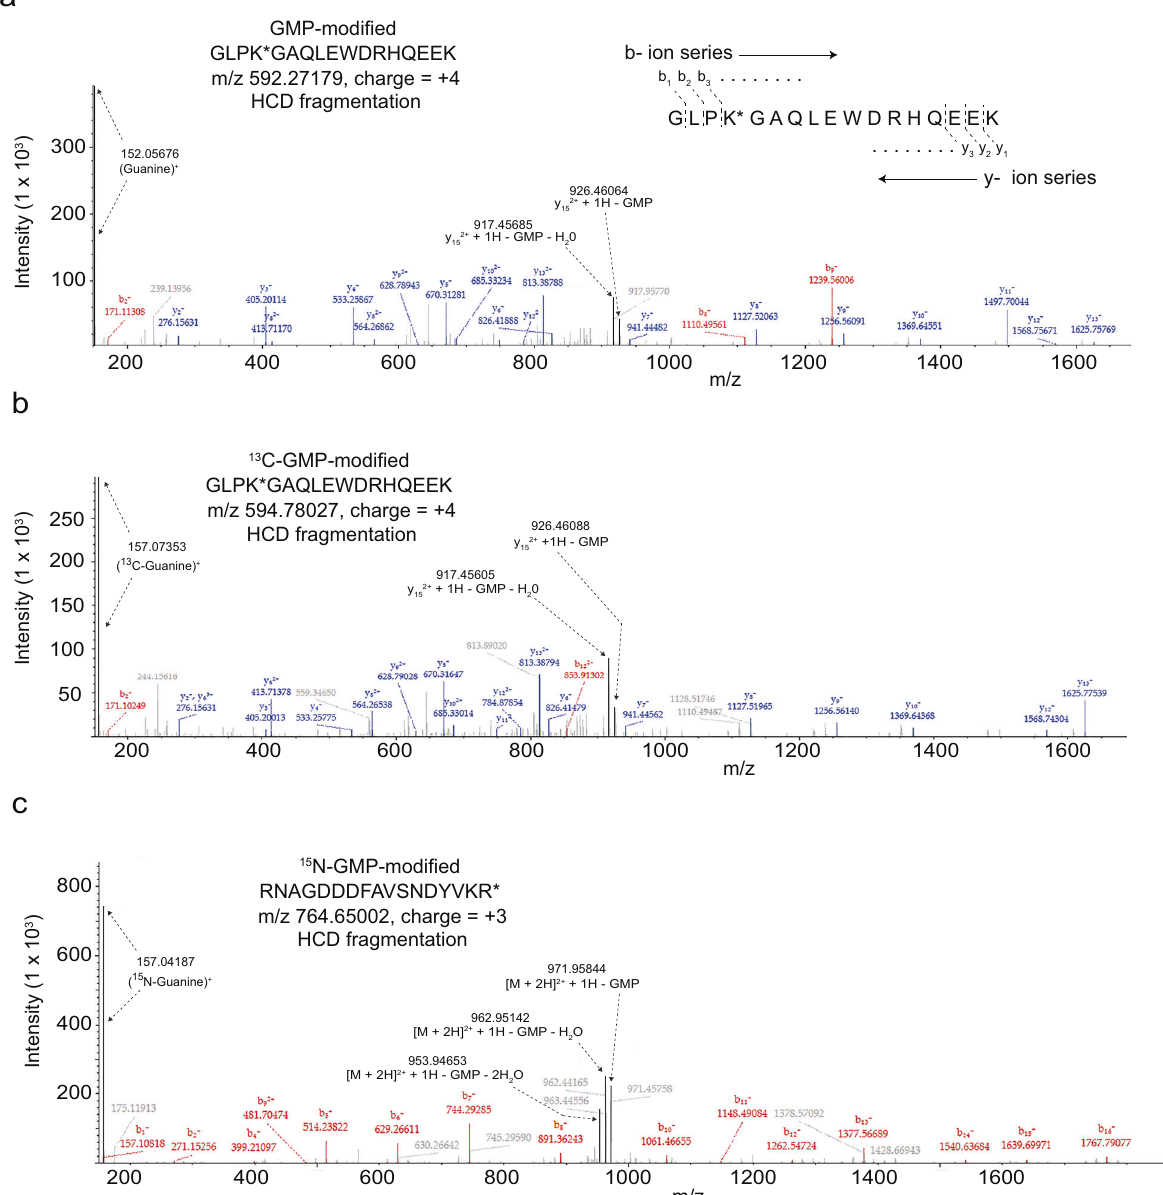
Fig. 3 MS/MS spectra of GMP, 15 N-GMP and 13 C-GMP modi fi ed peptides fragmented with HCD. a Top-scoring HCD peptide spectrum match for an EAV nsp7 peptide that is labeled close to the N-terminus with GMP. Ion series fragmentation for this peptide is illustrated. b Top-scoring HCD peptide spectrum match from an EAV nsp7 peptide that is labeled close to the N-terminus with 13 C-GMP. c Top-scoring HCD peptide spectrum match from an EAV nsp7 peptide that is labeled close to the C-terminus with 15 N-GMP. Note that Sequest HT assigned the 15 N-GMP modi fi cation to R17, instead of the correct site at K16. Spectra are additionally labeled with guanine fragment ions and dominant peptide fragments that have lost the GMP modi fi ed plus one or two H 2 O molecules. Asterisks indicate the assigned GMP-modi fi cation site. Red and blue coloring indicate b- fragment ions and y- fragment ions. The GMP-modi fi ed EAV peptides were observed at least two separate